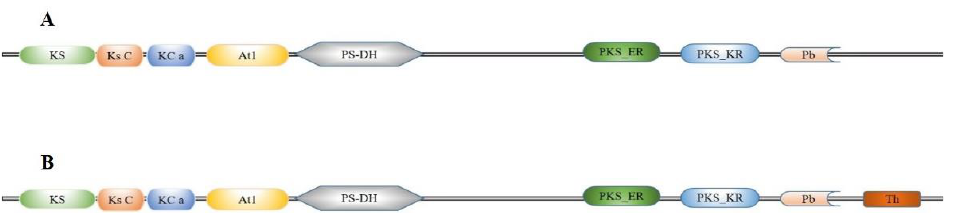
Figure 1. Domain schematic of SlFAS1 ( A ) and SlFAS2 ( B ) in S. litura . KS, Ketoacyl-synt (pfam00109); Ks C, Ketoacyl-synt_C (pfam02801); KC a, KAsynt_C_assoc (pfam16197); At1, Acyl_transf_1 (pfam00698); PS-DH (PF14765); PKS_ER (smart00829); PKS_KR (smart00822); Pb, PP-binding (pfam00550); Th, Thioesterase (pfam00975).